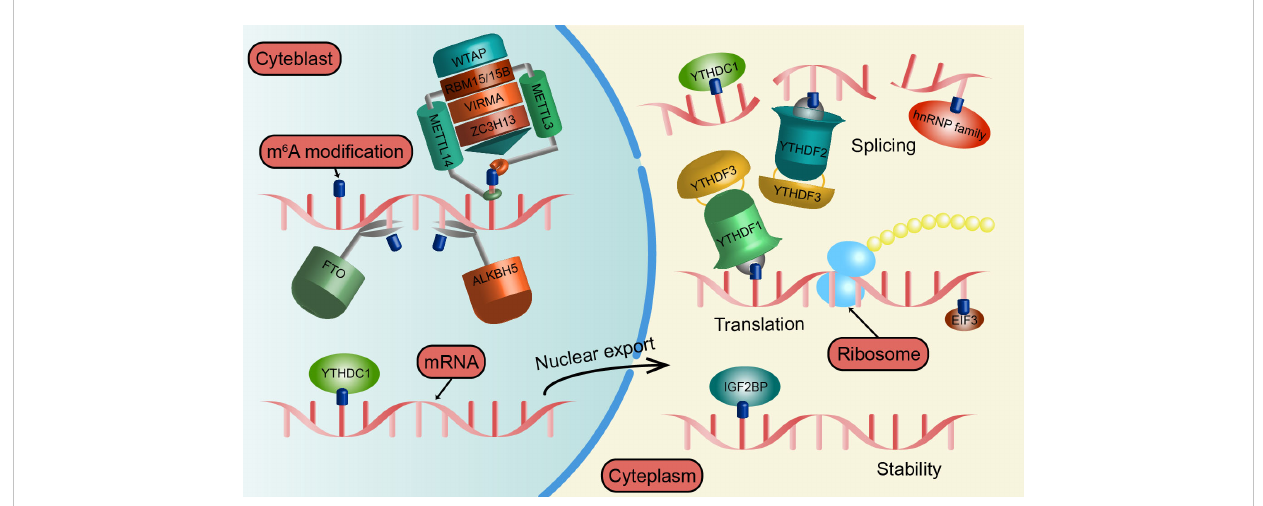
FIGURE 1 The regulation mechanism of m6A modi fi cation. METTL3, METTL14, WTAP, RBM15, VIRMA, and ZC3H13 all belong to the “ writers ” and catalyze the formation of m6A modi fi cation by constituting MTC. The “ erasers ” includes FTO and ALKBH5, which act as key proteins in m6A demethylation. YTHDF1/2/3, YTHDC1, IGF2BP, hnRNP family, and EIF3 as “ readers ” that bind to m6A and affect RNA splicing, output, translation, and